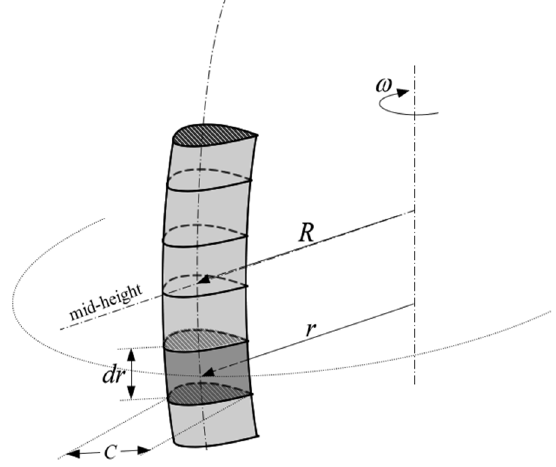
Figure 10. Discretization of the blade into n